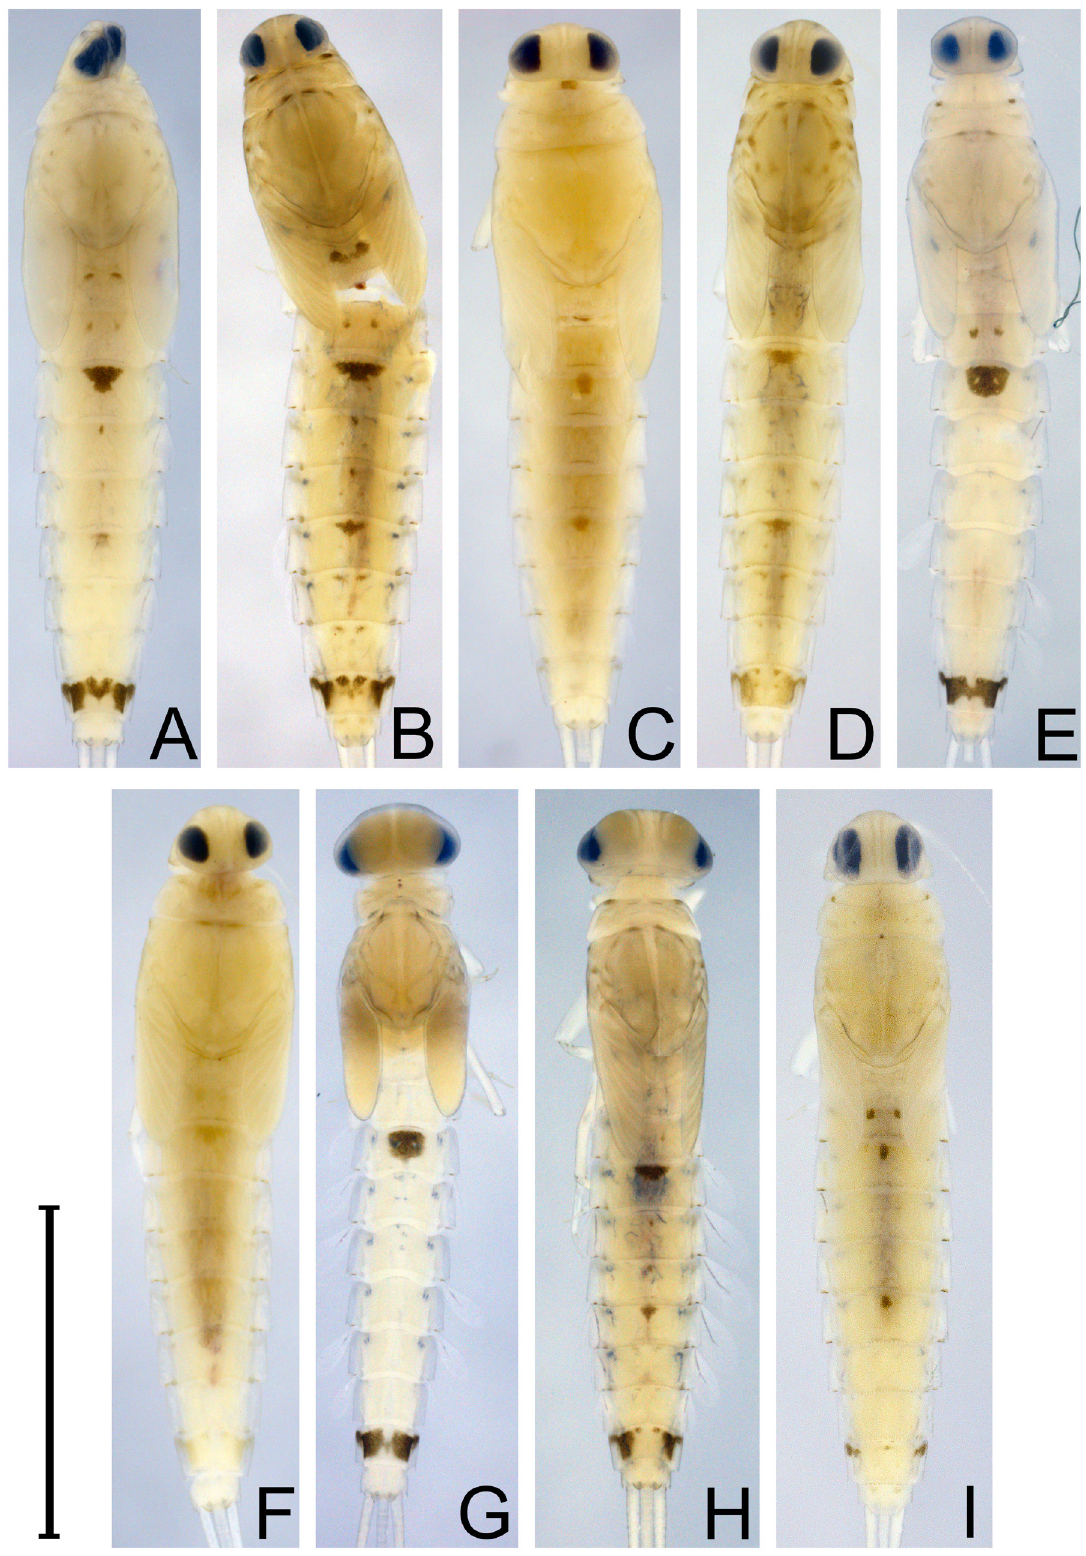
Fig. 11. Rivudiva oxum sp. nov., dorsal habitus of nymphs, variation of pigmentation pattern. A . Holotype on slide (INPA). B–I . Paratypes (INPA). Scale bar = 1.65